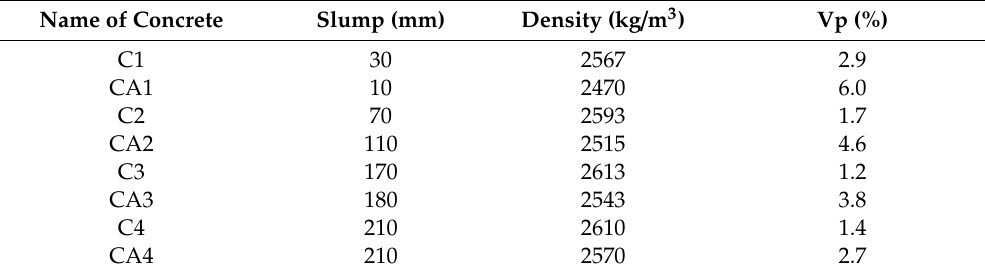
Table 4. The results of the concrete mix tests.